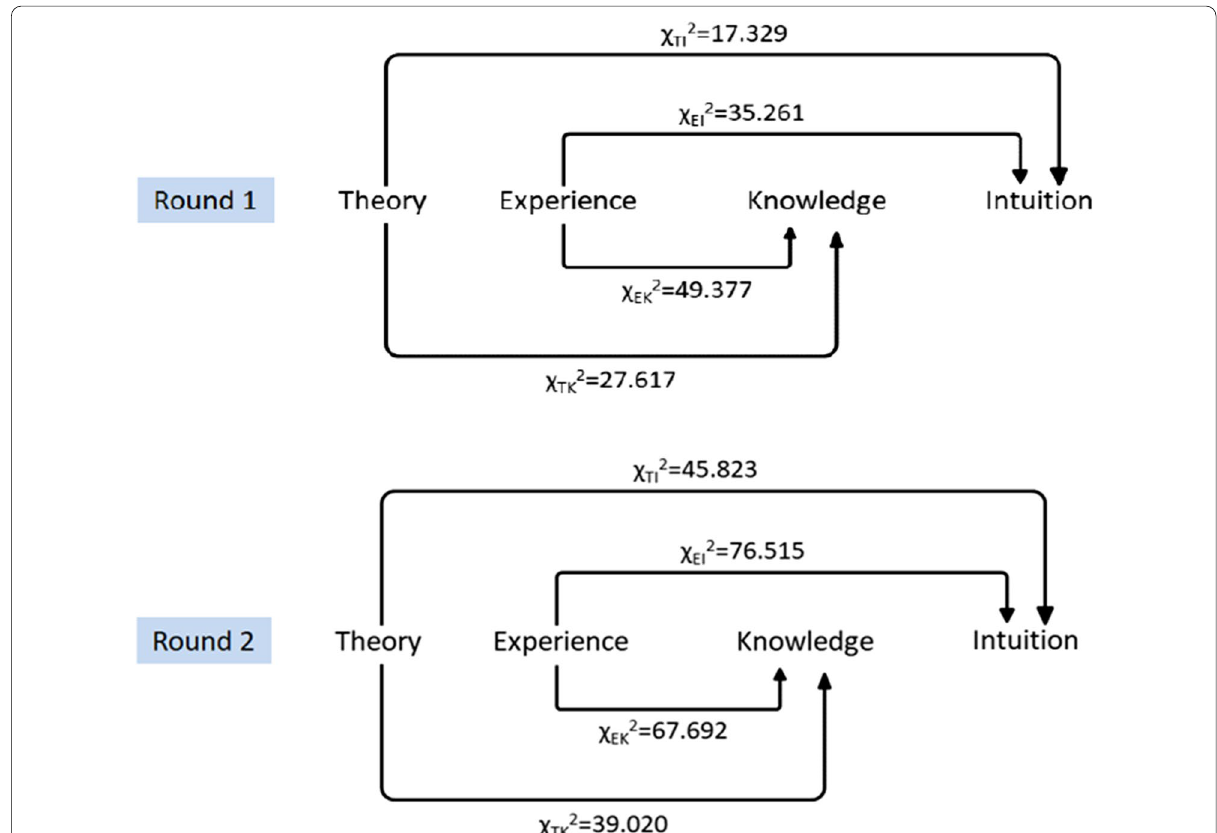
Fig. 3 The illustration of the comparison processes of four judgment bases in round 1 and round 2, separately. Note * P <